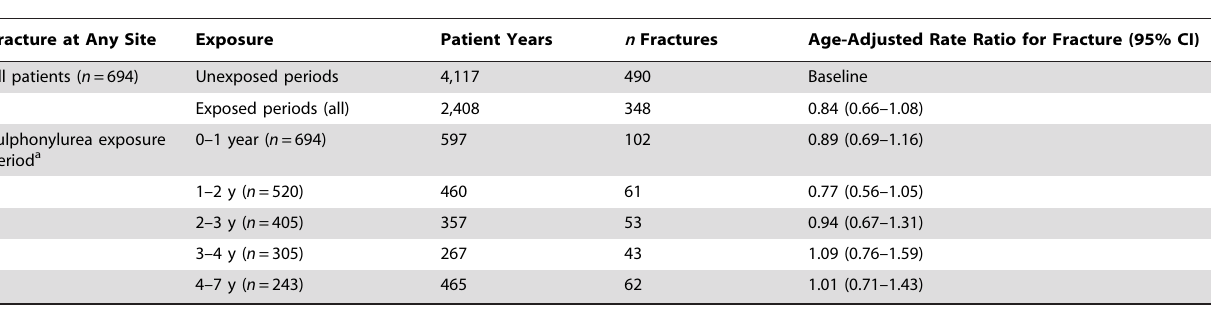
Table 4. Case-series analysis for sulphonylureas: association between exposure to any sulphonylurea and fractures.